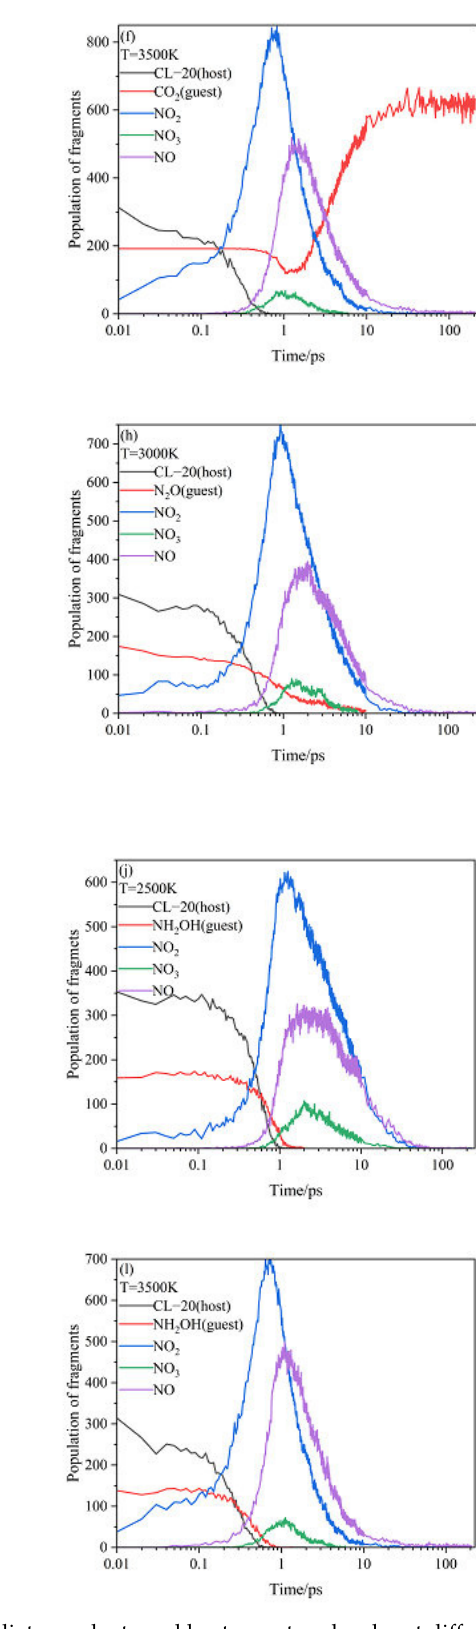
Figure 6. Evolution curves of the main intermediate products and host–guest molecules at different temperatures ( a – l ). Thick trendline corresponds to the actual concentration data of corresponding matching color.